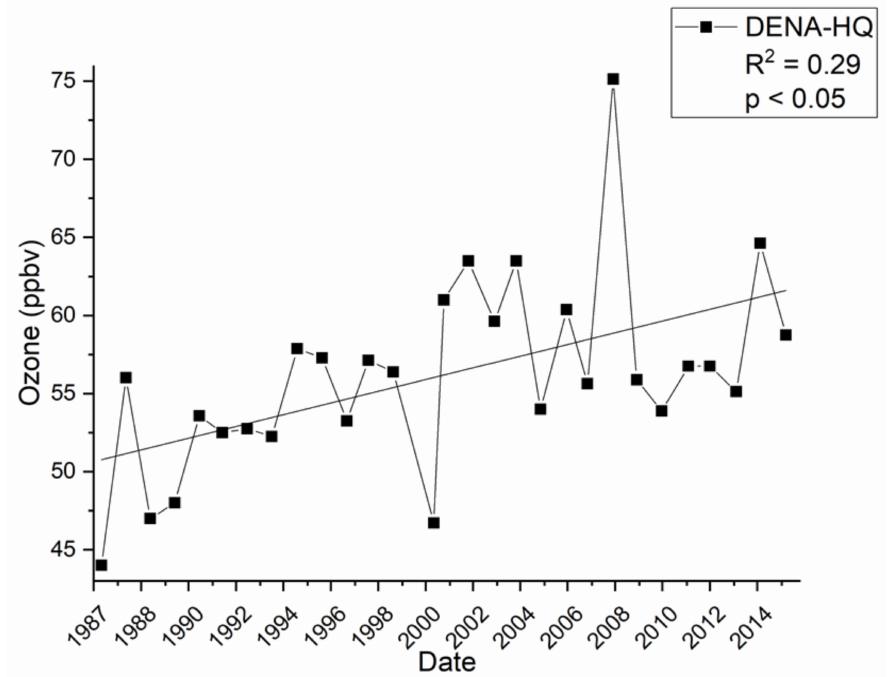
Figure 8. The annual 4th highest DM8HA at Denali National Park in Alaska (DENA-HQ) and a best fit linear regression line showing a coefficient of determination of